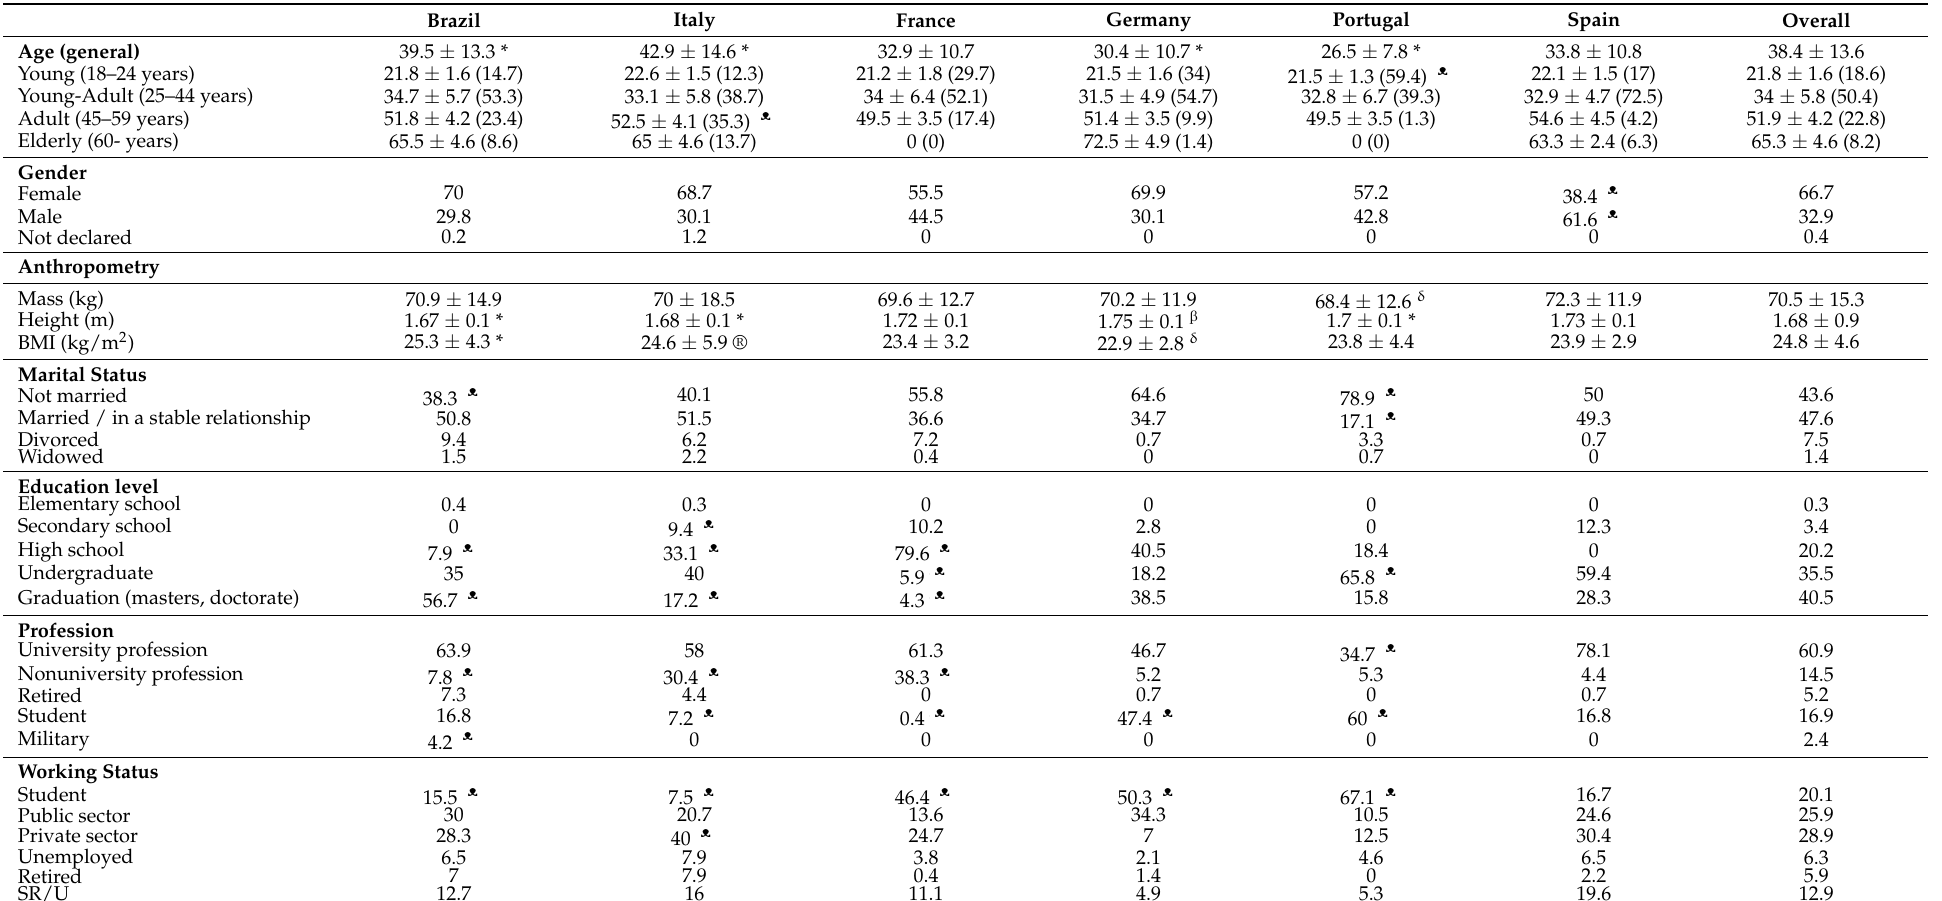
Table 1. Number of respondents per millions of people of the countries’ inhabitants. Table 2. Sociodemographic characteristics of the sample from Brazil ( n = 1845), Italy ( n = 680), France ( n = 236), Germany ( n = 143), Portugal ( n = 152) and Spain ( n = 138), aged from 18 years old ( n = 3195). Values are presented as mean ± SD or percentage (%).